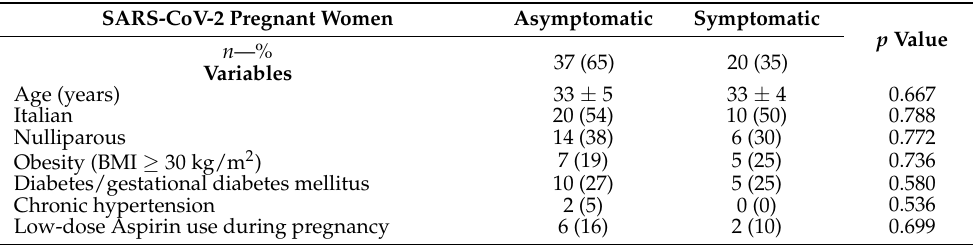
Table 2. Population characteristics comparing positive SARS-CoV-2 pregnant women with signs and symptoms of COVID-19 at the hospital admission vs. asymptomatic women [Mean; standard deviation—SD; n ;